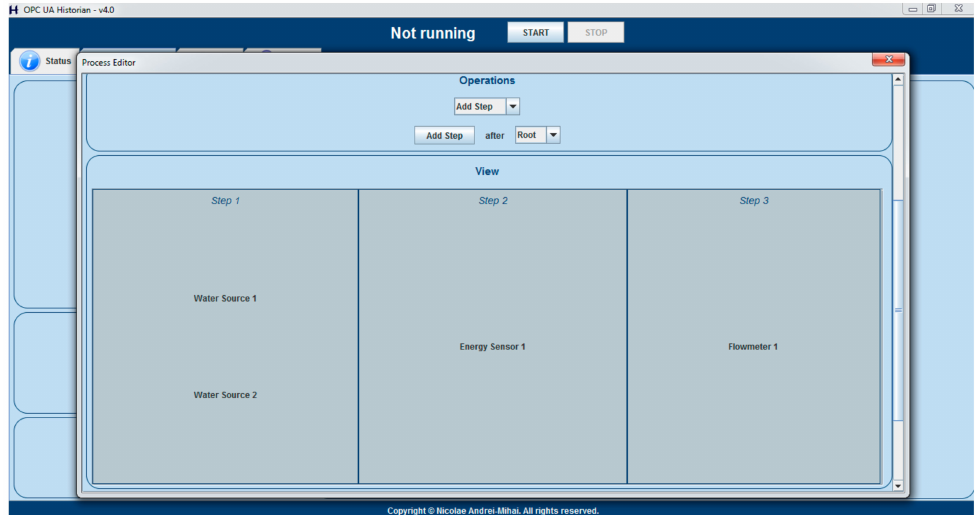
Figure 2. Example of the minimum objects that must be defined, inside the Historian Process Editor, for the currently used process, in order to execute the optimizing strategy.